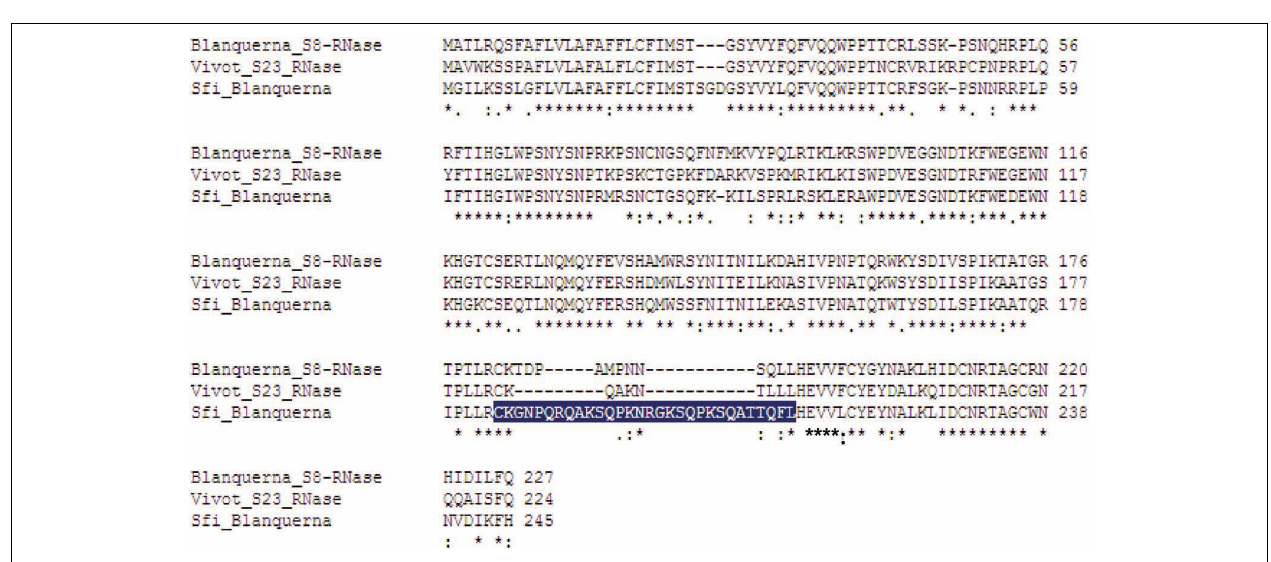
FIGURE 3 | Multiple sequence alignment of the S f , S 8 , and S 23 sequences of RNases, indicating the amino acid residues that belong to the “extended loop” in the S f 3D structure (marked in blue).